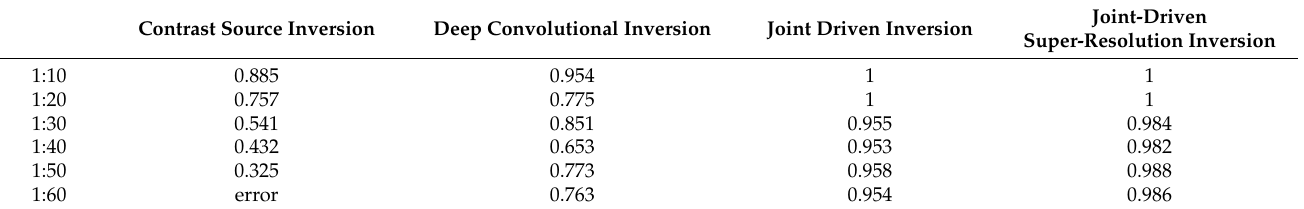
Table 4. IOU of each